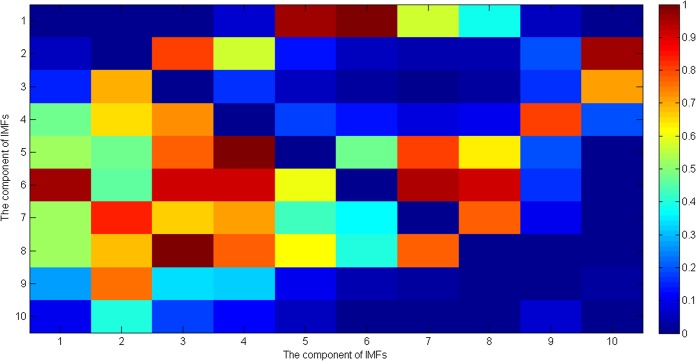

p values of Student’s t test of the entropy ratios of the instantaneous amplitude of ith and jth component of IMFs of the uterine EMG signals.